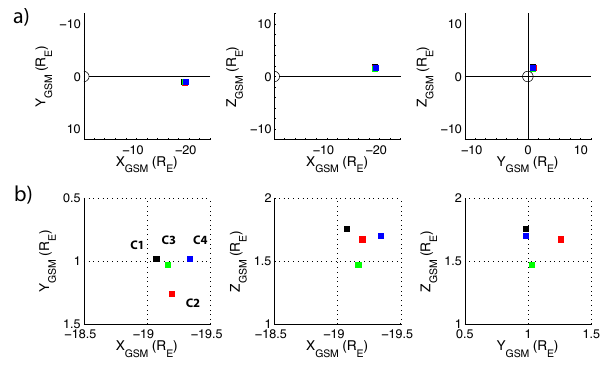
Figure 3. (a) Cluster spacecraft positions in GSM on 5 Septem- ber 2001 at 11:26UT. (b) Zoomed